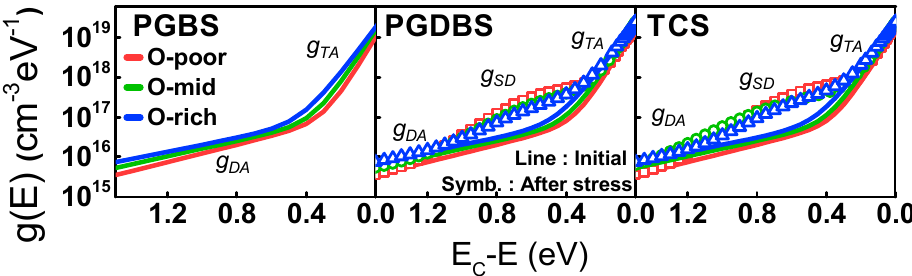
Figure 3. Density of states (DOS) over a range of O-content as stress time under positive gate bias stress (PGBS), positive gate and drain bias stress (PGDBS), and target current stress (TCS). Lines denote the initial state, and symbols indicate values after each stress condition.